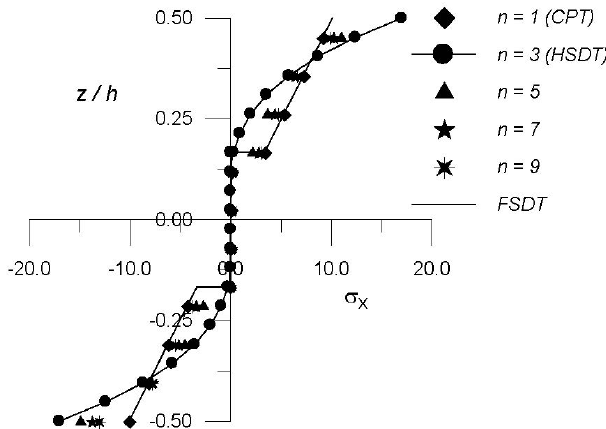
Figure 11: Through thickness distribution of bending stress ( ¯ σ x ) for simply supported three layered (0 ∘ /90 ∘ /0 ∘ ) symmetrically lami-